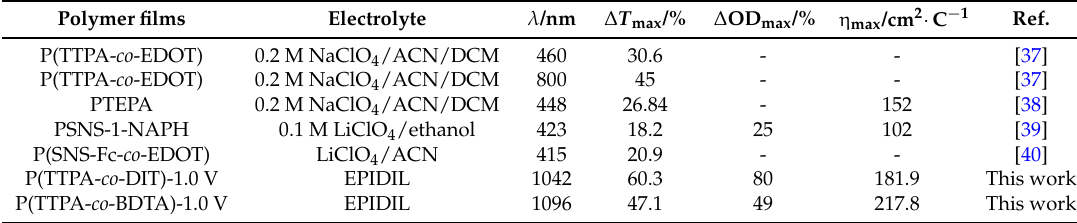
Table 4. Summary of ∆ T max and η max for various polymer